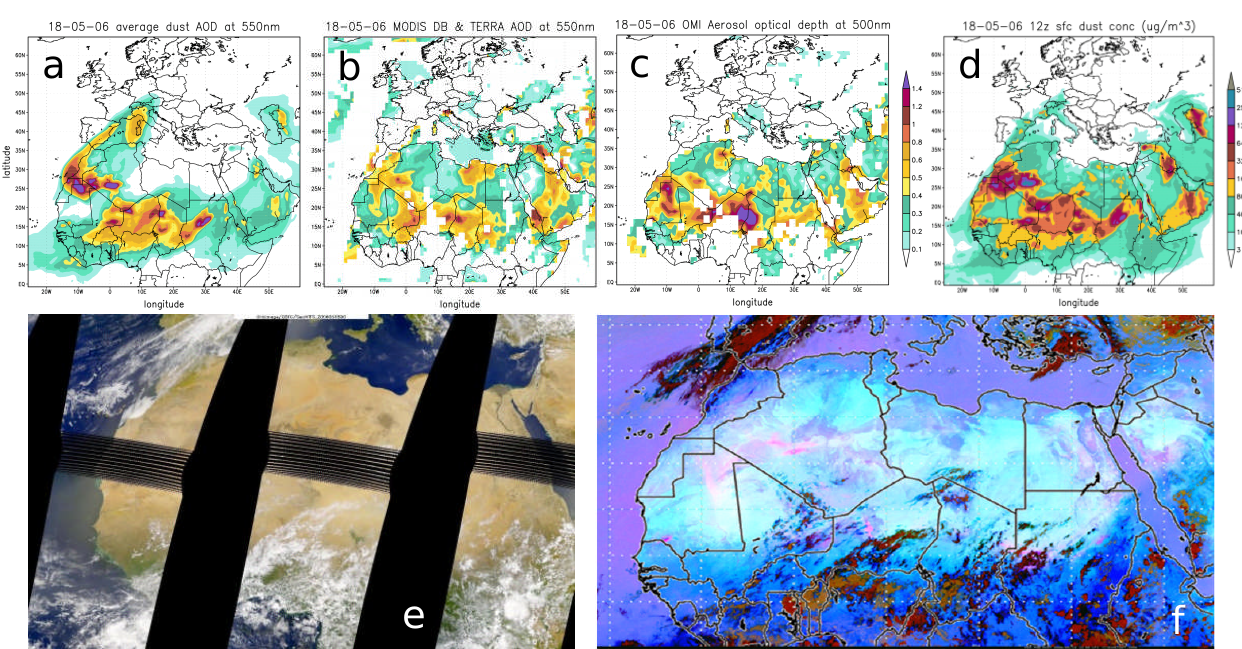
Fig. 4. The same as in Fig. 2, but for 18 May